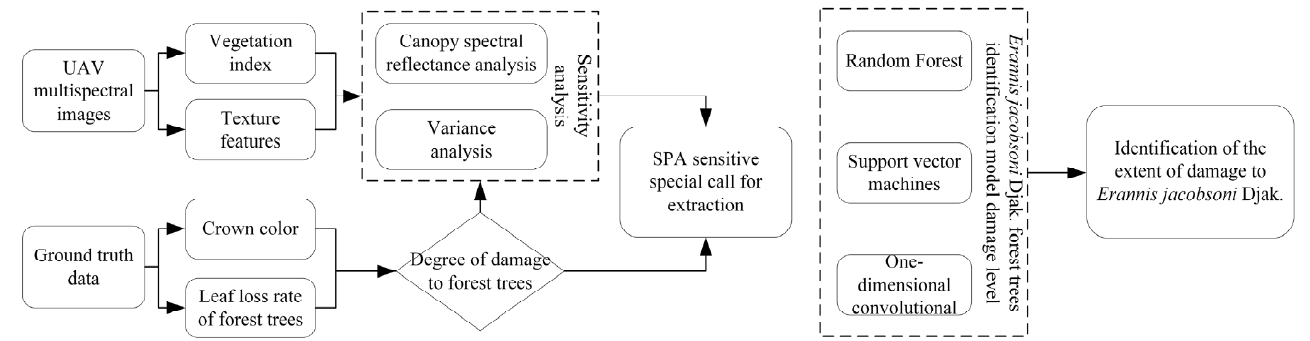
Figure 2. The general workflow of the